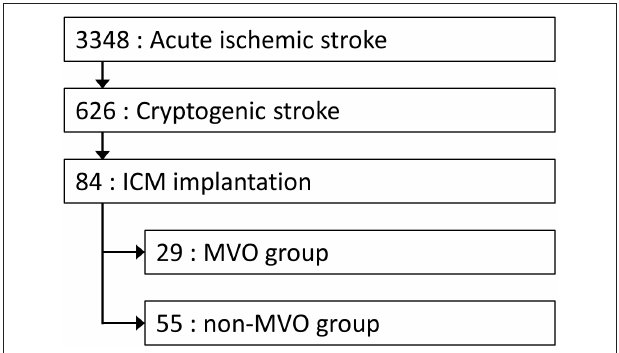
FIGURE 1 | Flowchart of Study Population. Among 3,348 patients with acute ischemic stroke, 84 consecutive patients with insertable ICM implantation were enrolled in the current analysis. ICM, insertable cardiac monitoring; MVO, major vessel occlusion.